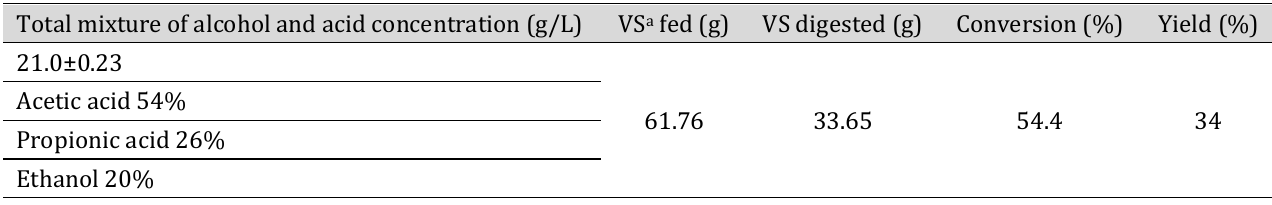
Table 2. GC-MS analysis of batch fermentation products of white sorghum biomass using MixAlco process.